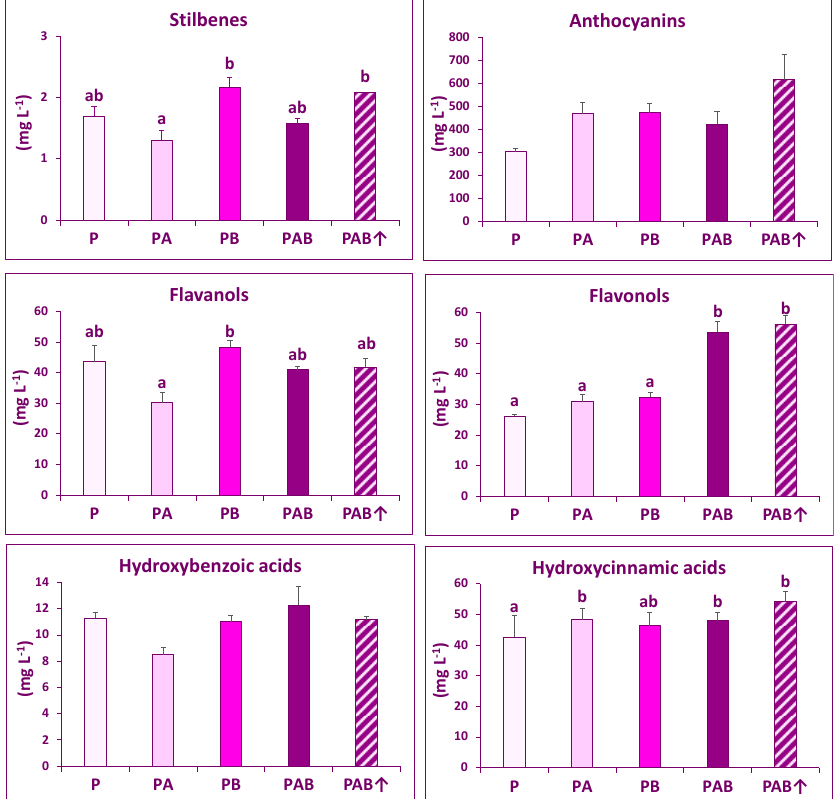
Figure 1. Contents of phenolic families in the wines made from grapes exposed to five different radiation regimes: P (only PAR), PA (PAR + UV-A), PB (PAR + UV-B), PAB (PAR + UV-A + UV-B), and PAB ↑ (PAR + UV-A + enhanced UV-B). For each variable, different letters indicate significant differences between radiation regimes (post hoc Tukey test after a one- way ANOVA test using radiation regime as main factor). Means ± SE are shown. No significant difference between PAB and PAB ↑ samples was found for the total concentrations of phenolic families or for individual phenolic compounds (Figure 1, Table 1).